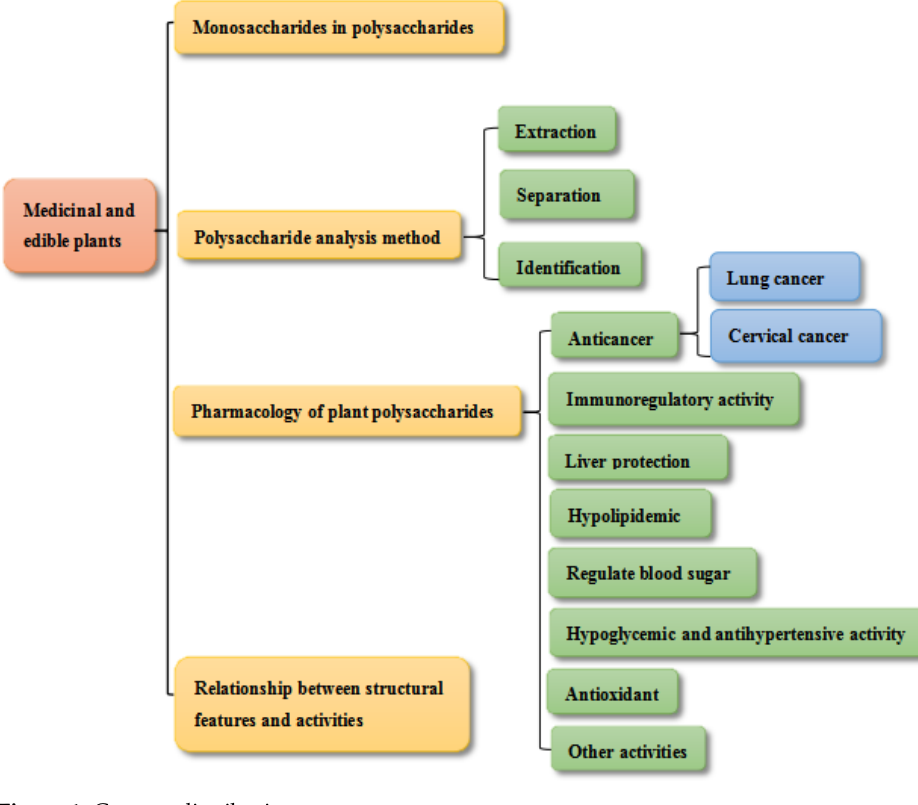
Figure 1. Content distribution map.